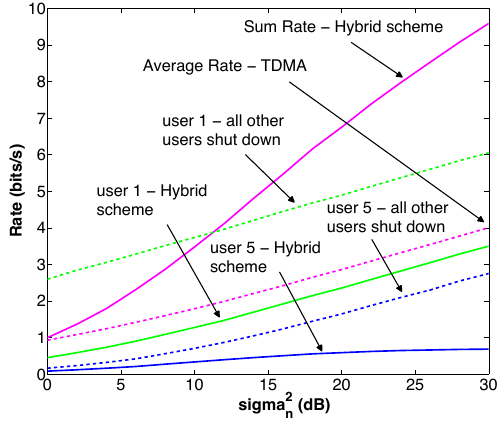
Figure 8. Rate Performance of the network and every user separately (SISO BC). The closer a user is to the basestation, the better their rate performance is.